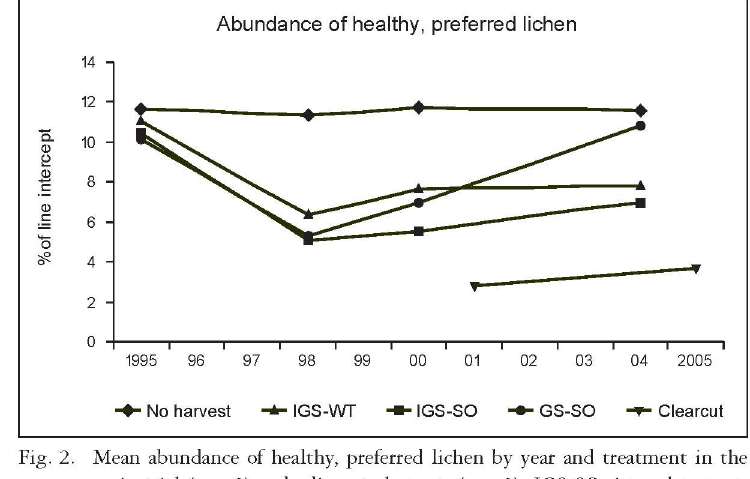
Fig- 2- Mean abundance of healthy, preferred lichen by year and treatment in the main trial (n = 5) and adjacent clearcuts (n = 3)- IGS-SO: irregular